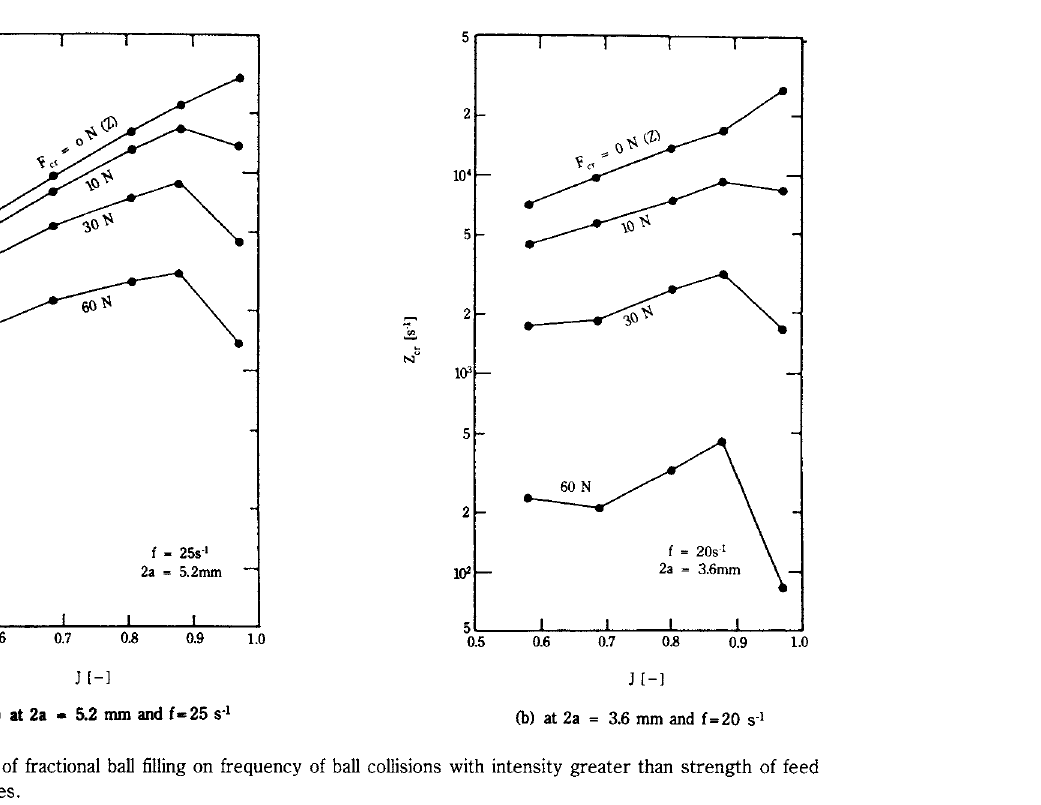
Fig. 21 Effect of fractional ball filling on frequency of ball collisions with intensity greater than strength of feed particles.